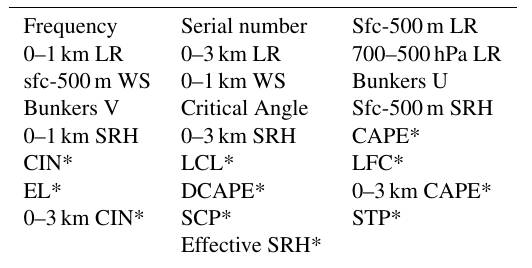
Table 3. A list of sounding parameters that are calculated and available in the radiosonde files. Variables marked with an aster- isk were calculated for surface based, most unstable, and the lowest 100hPa mixed parcels. “LR” denotes “lapse rate”, while “WS” de- notes “wind